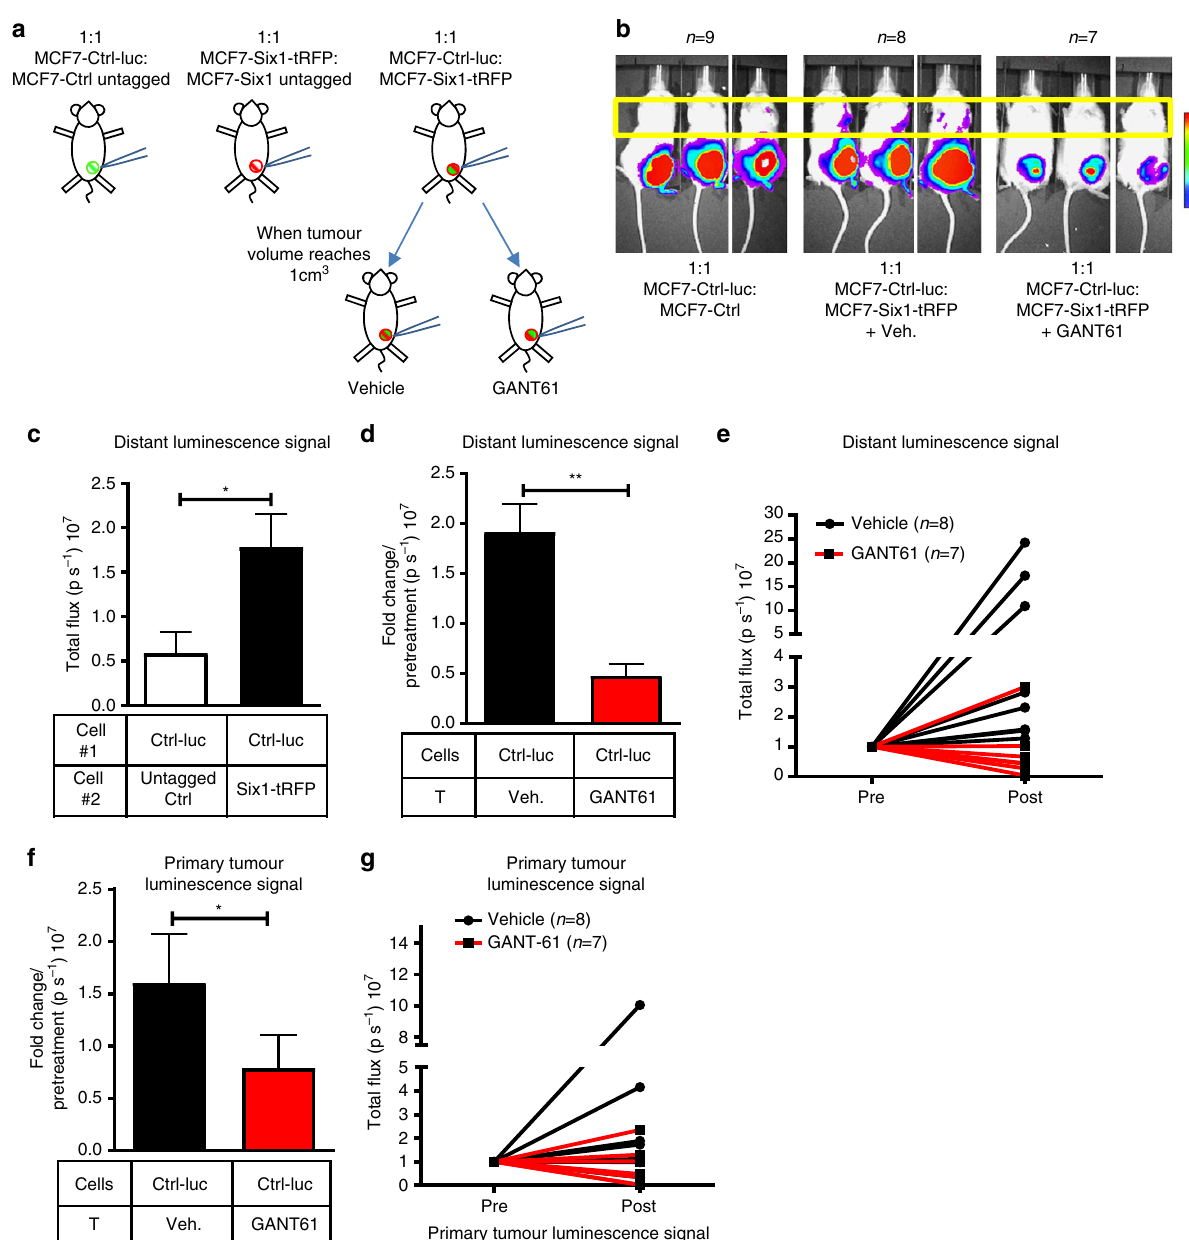
Figure 6 | GANT61 inhibits NCA increase in metastasis in vivo. ( a ) Diagrammatic representation of the metastasis experiment. Female NOG/SCID mice were orthotopically injected in the fourth mammary fat pad with either MCF7-Ctrl-luc/MCF7-Ctrl-untagged (1:1) or MCF7-Six1-tRFP/MCF7-Six1-untagged cells (1:1) or co-injected with MCF7-Ctrl-luc and MCF7-Six1-tRFP cells (1:1). Mixed tumours were treated with 50mgkg (cid:2) 1 of GANT61 or vehicle (Veh.) every other day for 18 days once tumour volume reached 1cm 3 . ( b ) Representative bioluminescent imaging of mice (detecting ONLY the MCF7-Ctrl-luc cells) performed at similar tumour volumes for MCF7-Ctrl-luc and mixed injection groups ± GANT61 treatment. ( c ) Quantification of specifically the MCF7-Ctrl-luc signal (in lymph nodes/lungs, yellow boxed region in b ) in MCF7-Ctrl-luc and mixed injection þ vehicle treatment groups; represented as ps (cid:2) 1 , photons per second. ( d , f ) Quantification of specifically the MCF7-Ctrl-luc signal from ( d ) distant sites and ( f ) primary tumour in mixed tumours groups þ / (cid:2) GANT61 treatment, represented as fold change over pre-treatment signal. ( e , g ) Normalized luminescent signal from ( e ) distant sites and ( g ) primary tumours of individual mice pre- and post treatment. T, Treatment; s.e.m. shown, two-tailed unpaired t -test for all cases, * P o 0.05 and ** P o 0.01.